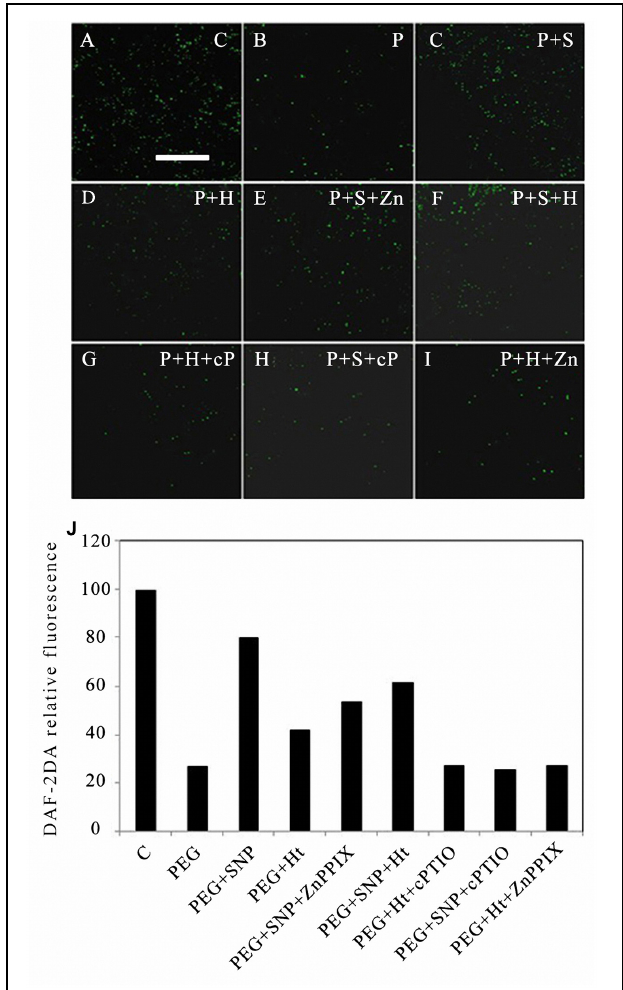
FIGURE 2 | Ht, SNP, ZnPPIX, and cPTIO raised or reduced endogenous NO content in rice aleurone layers under drought stress. Rice aleurone layers were treated with or without 20% PEG (P), 1 μ M Ht (H), 200 μ M SNP (S), 10 μ M ZnPPIX (Zn), and 200 μ M cPTIO (cP) individually or in combination for 24 h. A sample with distilled water was used as control (C). After various treatments, the aleurone layers were, respectively, stained with DAF-2DA, and then thoroughly washed to removal excess dye and immediately observed under a LSCM. Images of the distribution of NO in fluorescently labeled aleurone cells were captured (A–I) . The relative DAF-2DA fluorescence intensity in the corresponding aleurone layers was also established (J) . Scale bar, 100 μ m. Mean values were calculated from at least three independent experiments, bars with different letters indicate statistically significant differences at the 0.05 level, according to Duncan’s multiple